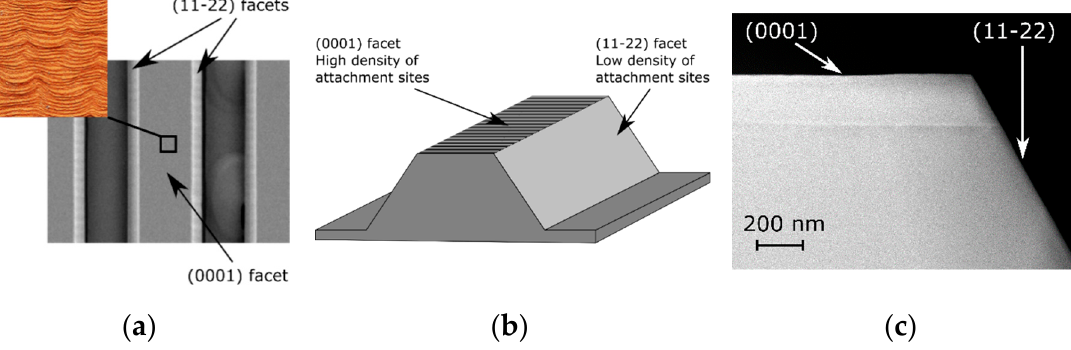
Figure 11. (a ) Top-view SEM image of the structure grown on substrate with stripes. Image size 40 × 30 µm. Inset: 2 × 2 µm AFM image acquired on the top of a 10 µm wide stripe. ( b ) Schematic perspective view of the structure. The top of the stripe is formed of the vicinal (0001) plane and the sidewalls are exact-oriented (11–22) planes. ( c ) Cross-sectional scanning transmission electron microscopy (STEM) image.